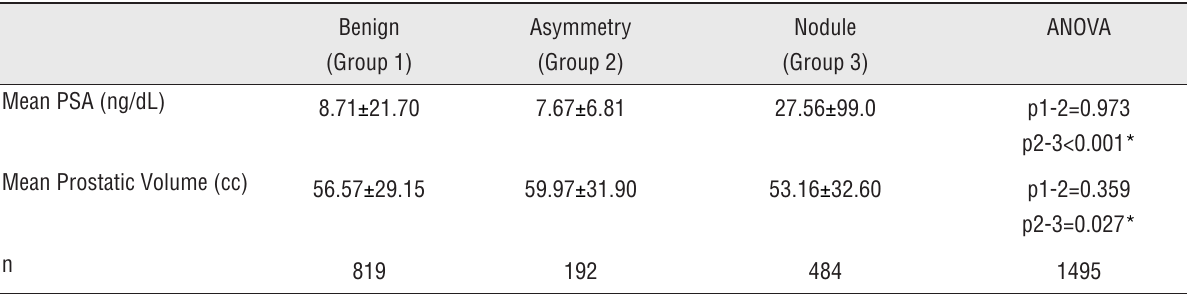
Table 2 - Mean psA level and prostatic volume of 1495 patients.